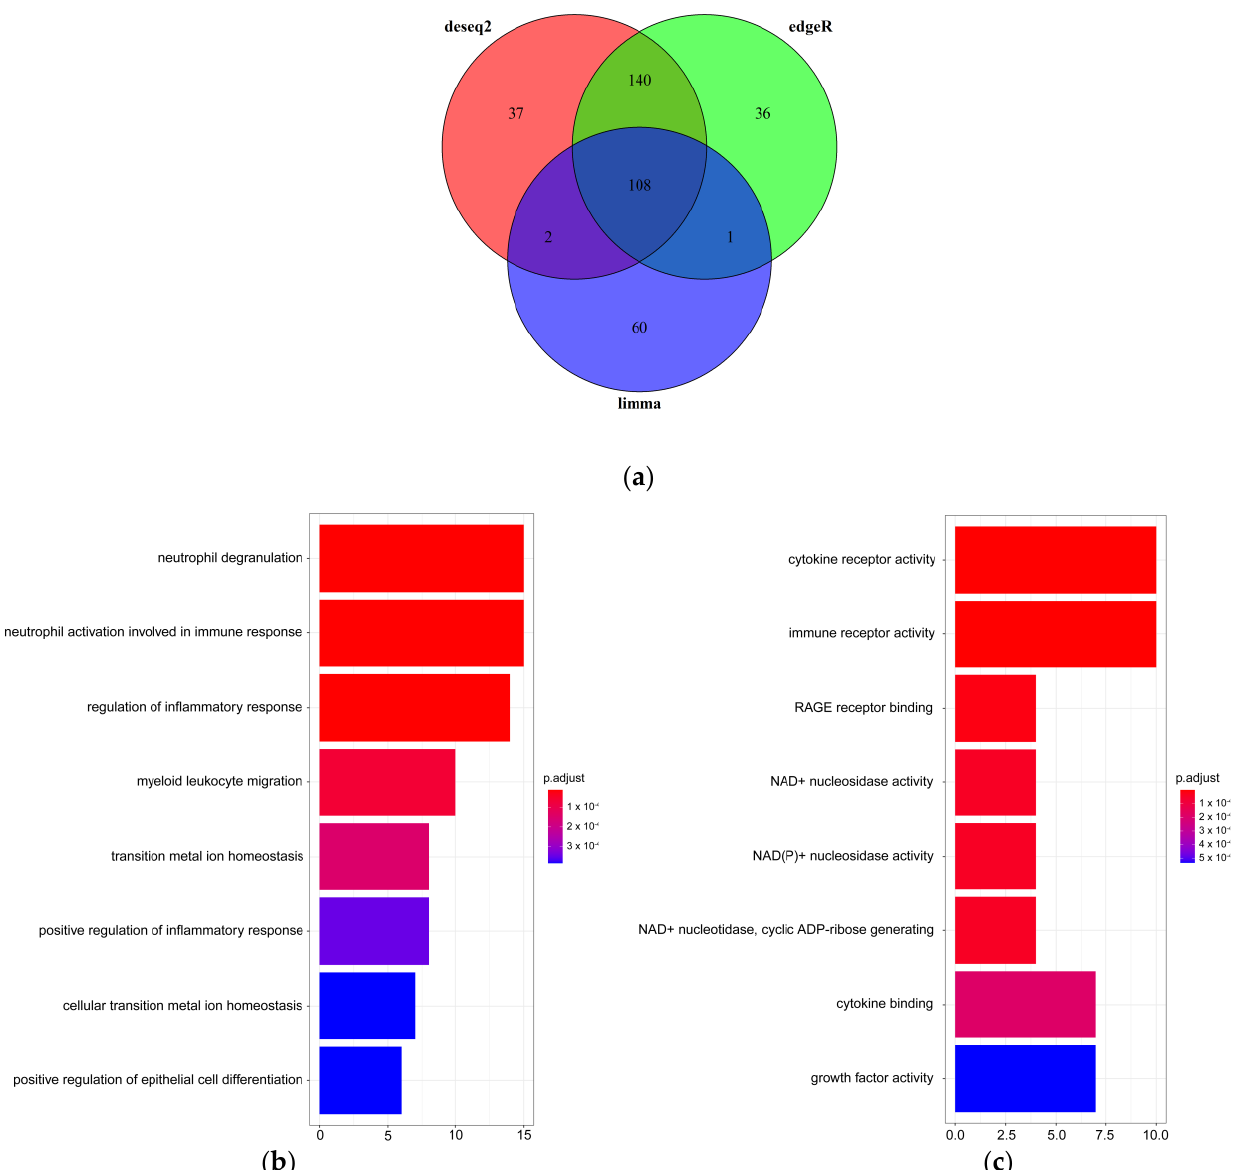
Figure 2. DEGs and related pathways of bulk RNA-seq. ( a ) Venn diagram of DEGs by three differential expression algorithms (DEseq2, LIMMA, and edgeR); ( b , c ) The top significantly overrepresented GO BP and MF terms. The x-axis represents the count of genes. The y-axis indicates the items of GO BP. The color represents the value of the FDR-adjusted p -value.